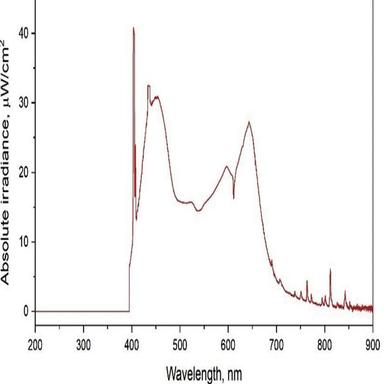
Spectrum of the fluorescent light source used for photocatalytic testing (with 395 nm long-pass filter).